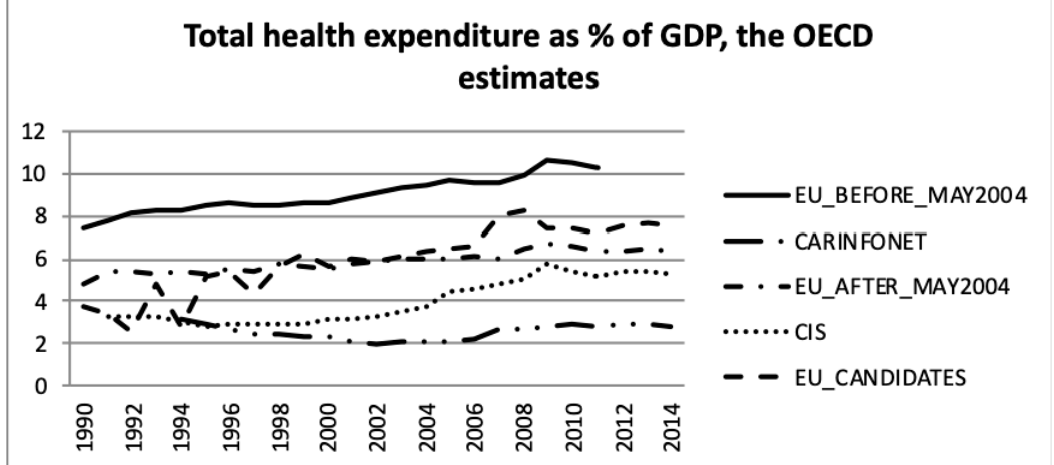
Figure 2. Total health expenditure as a percentage of Gross Domestic Product (GDP), the Organisation for Economic Co-operation and Development (OECD) estimates.